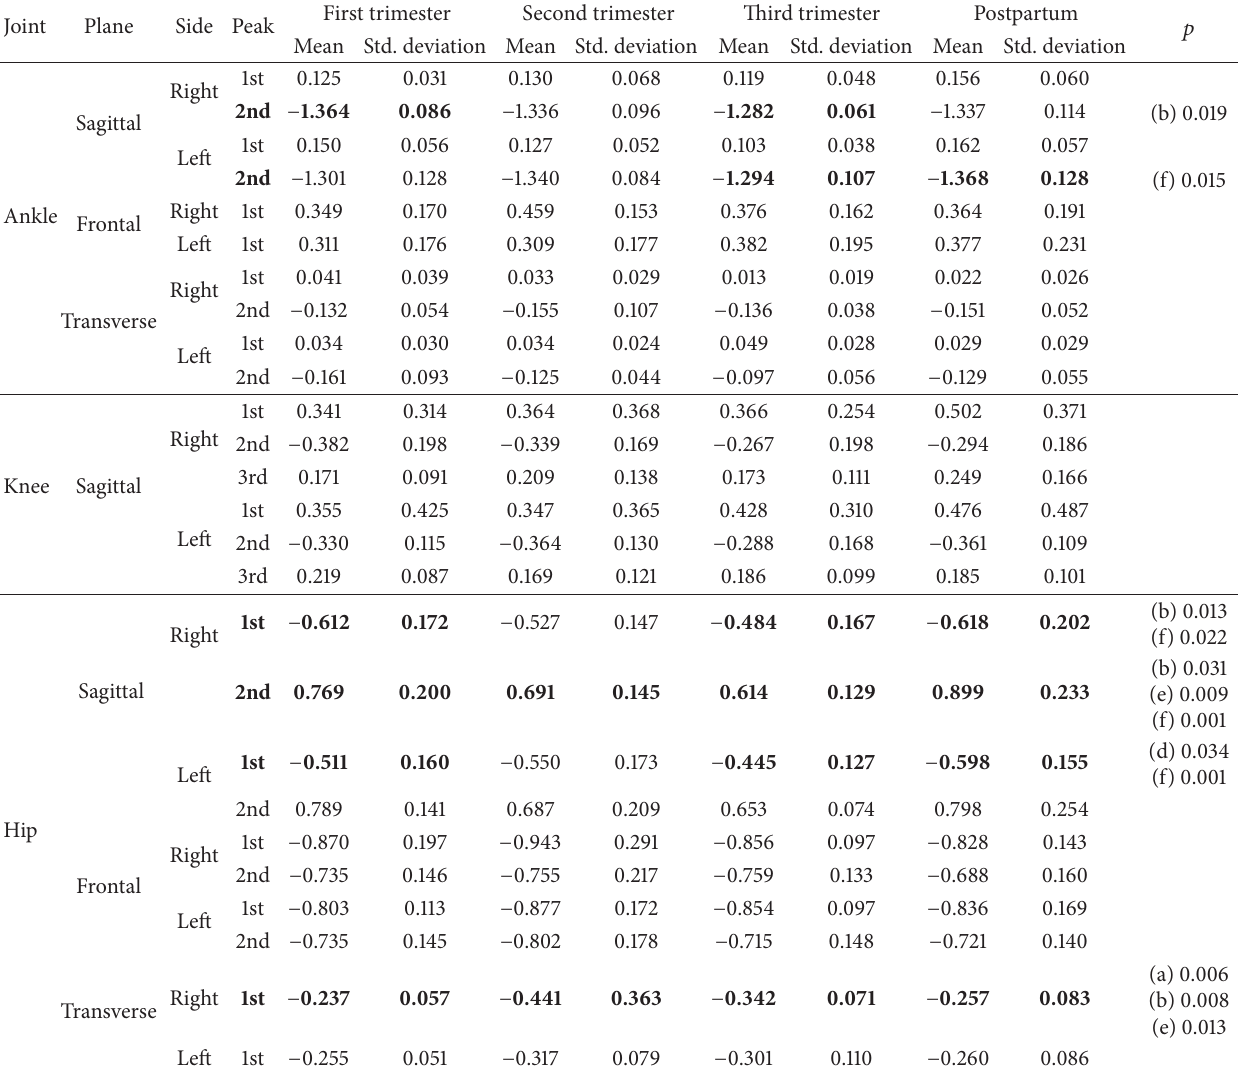
Table 2: Mean and standard deviation of the joint moment peaks, and significance levels of the pairs of collections with significant changes for sagittal, frontal, and transverse